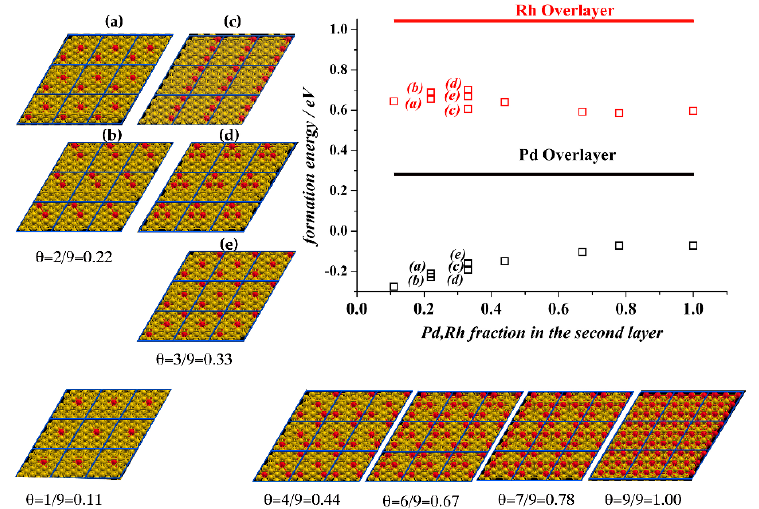
Figure 1. Different modeled fractions of Pd and Rh (ML) in the second layer of Au(111) and their corresponding formation energy (Equation (1)). The (3 × 3) unit cell is shown in blue lines. Gold atoms are presented in yellow spheres. Rh/Pd atoms in the second layer are represented as red spheres.